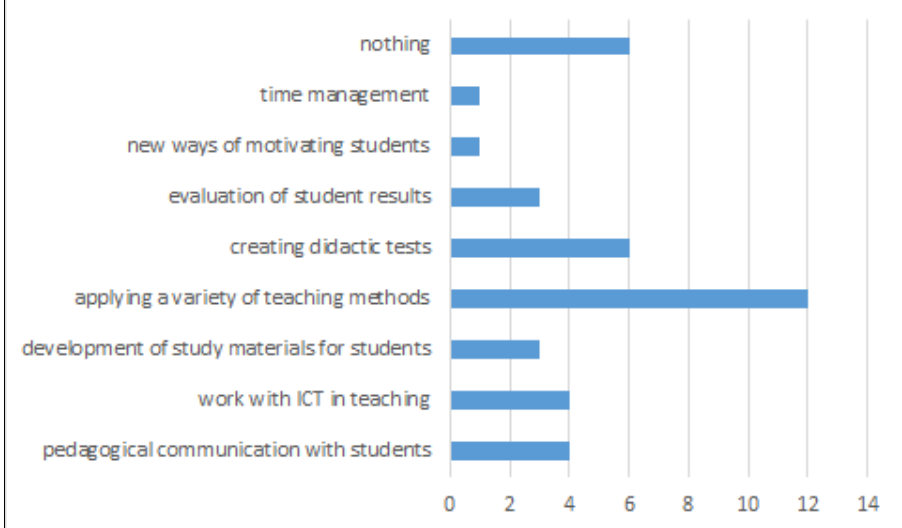
Figure 2. Areas of weaknesses in their own teaching as perceived by lecturers (multiple answers were possible)